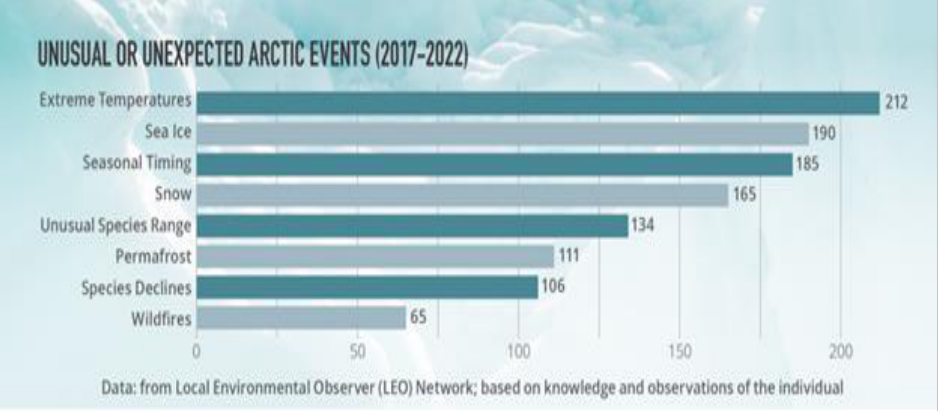
Figure 1. Unusual or unexpected Arctic events from the Local Environmental Observer (LEO) database.